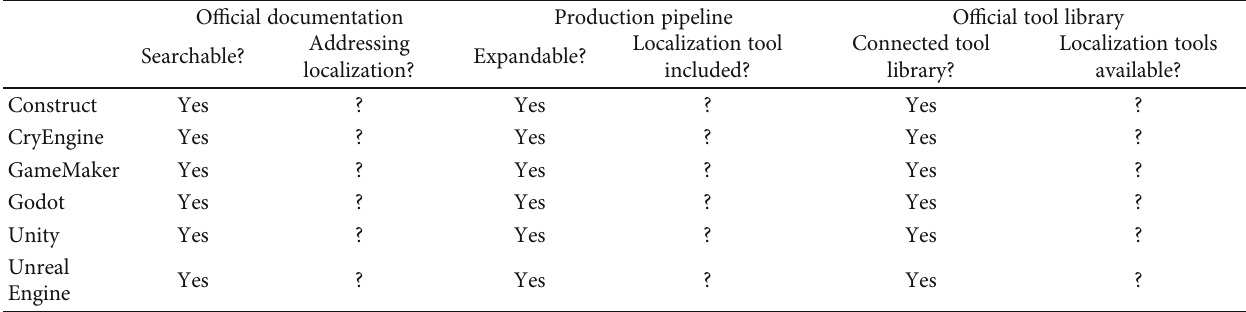
Table 2: Overview of the general purpose game engines included in the